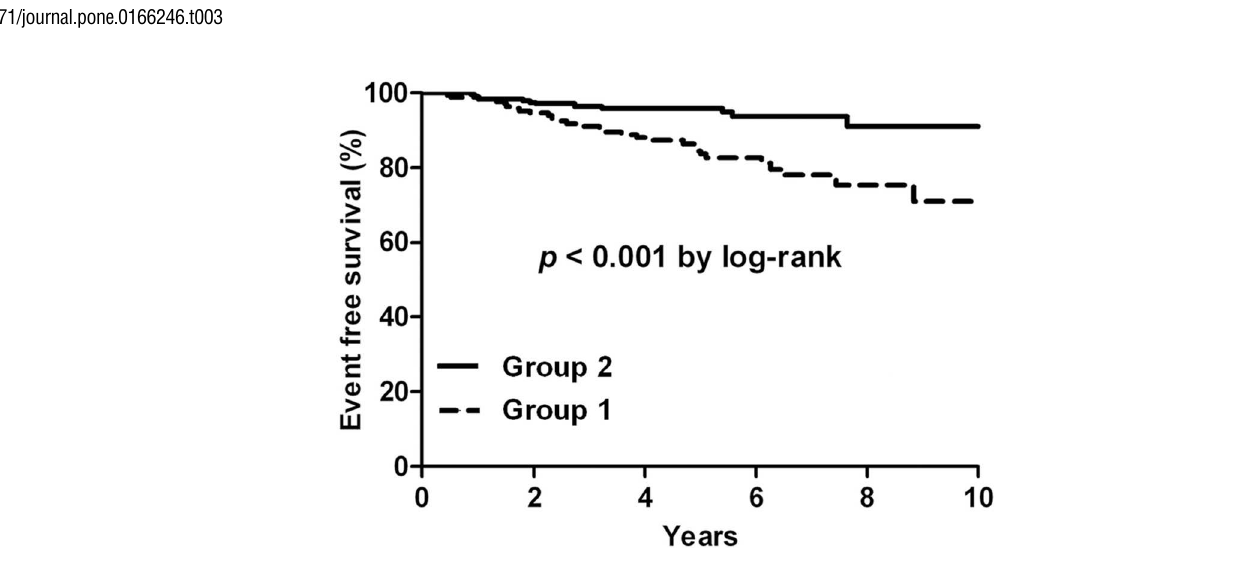
Fig 2. Kaplan-Meier curves for patients classified by statin